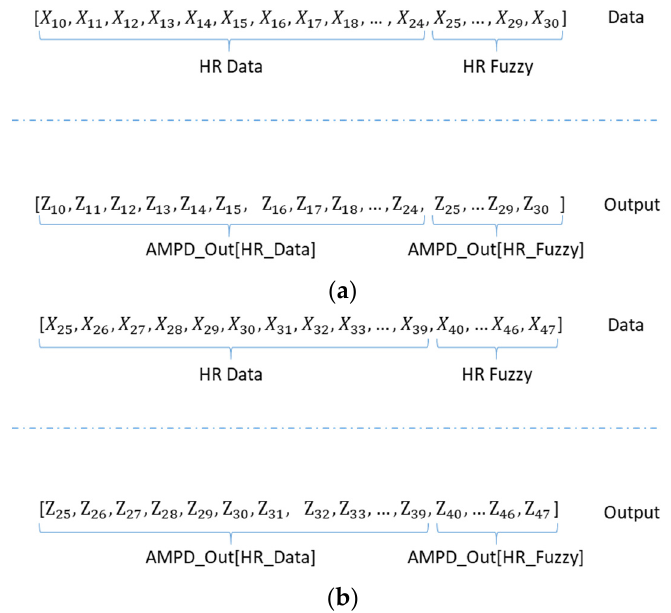
Figure 15. ( a ) The first window cycle of AMPD_Out vector with HR_Fuzzy = 6; ( b ) The second window cycle of AMPD_Out vector. (HR_Fuzzy = 8).